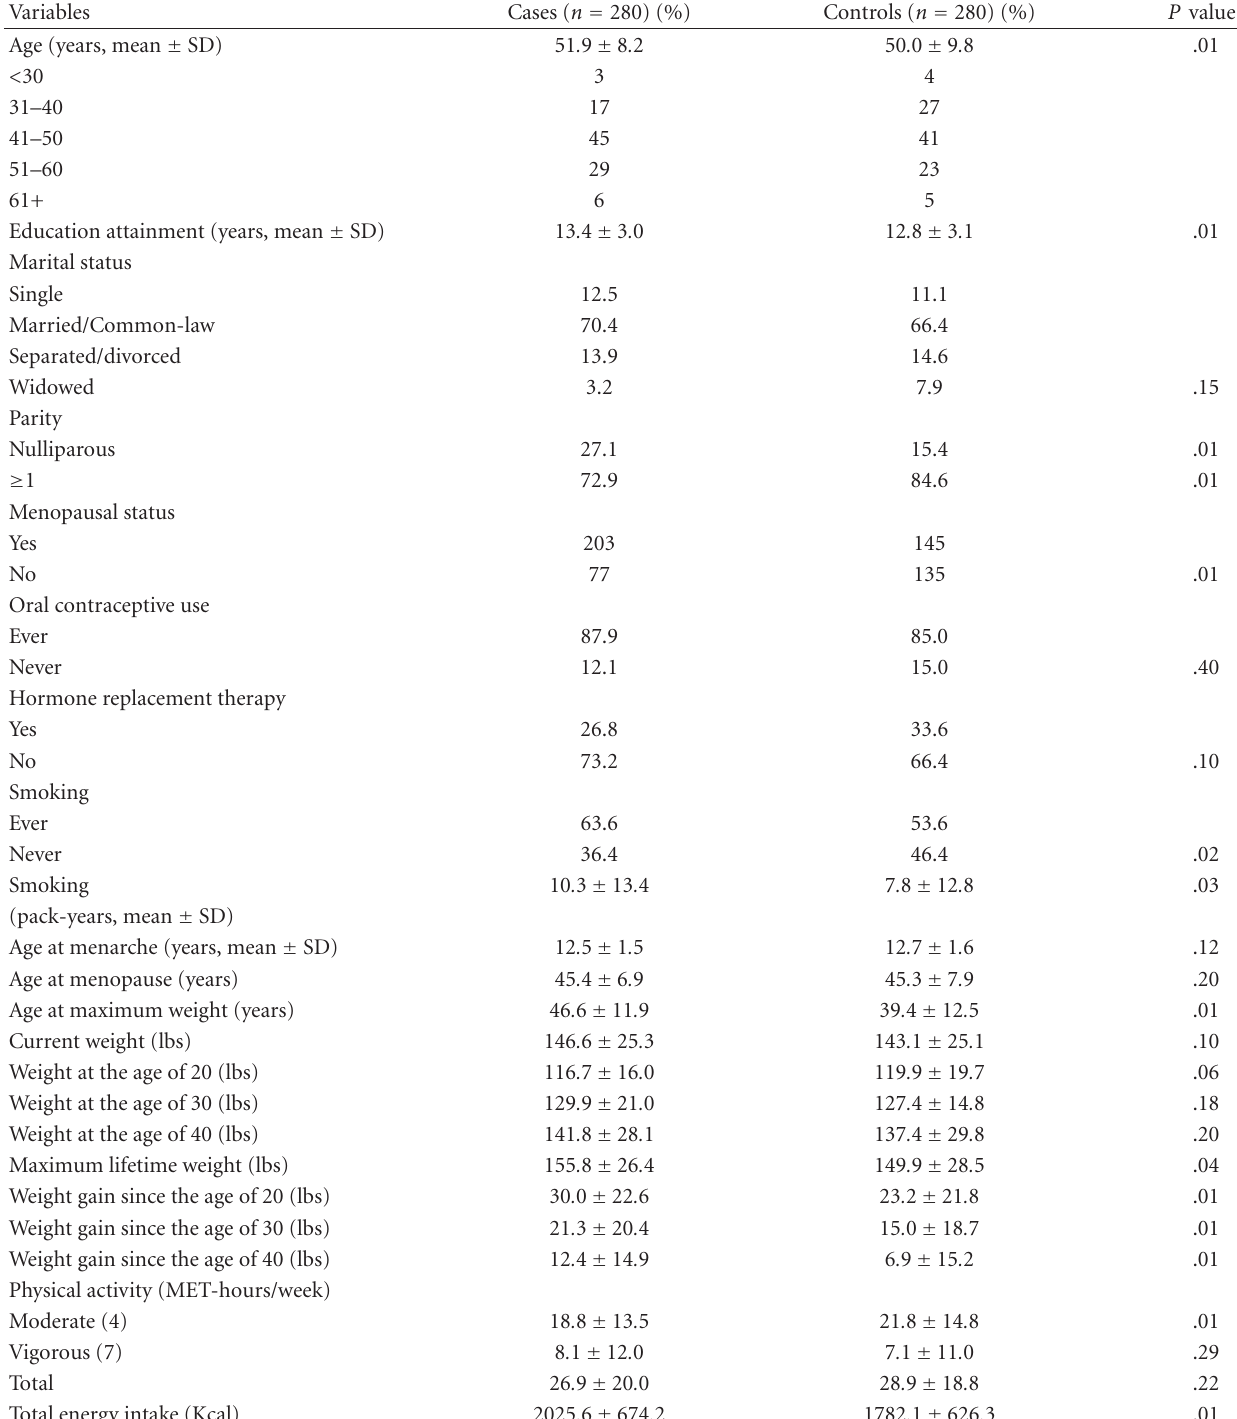
Table 1: Selected characteristics of the study